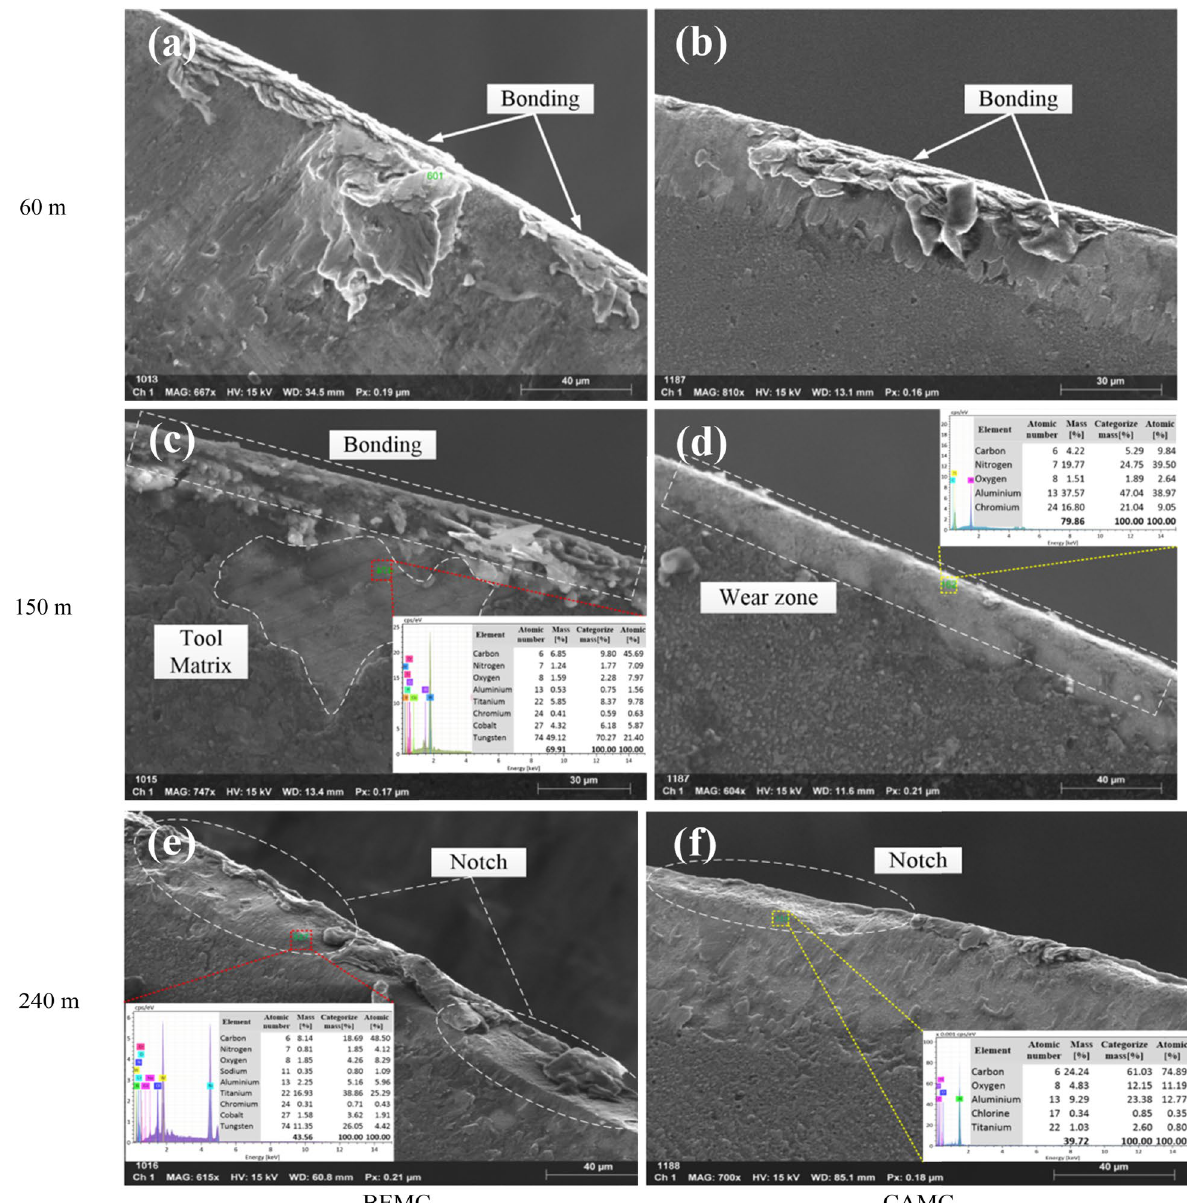
Figure 5 Flank wear morphology at different